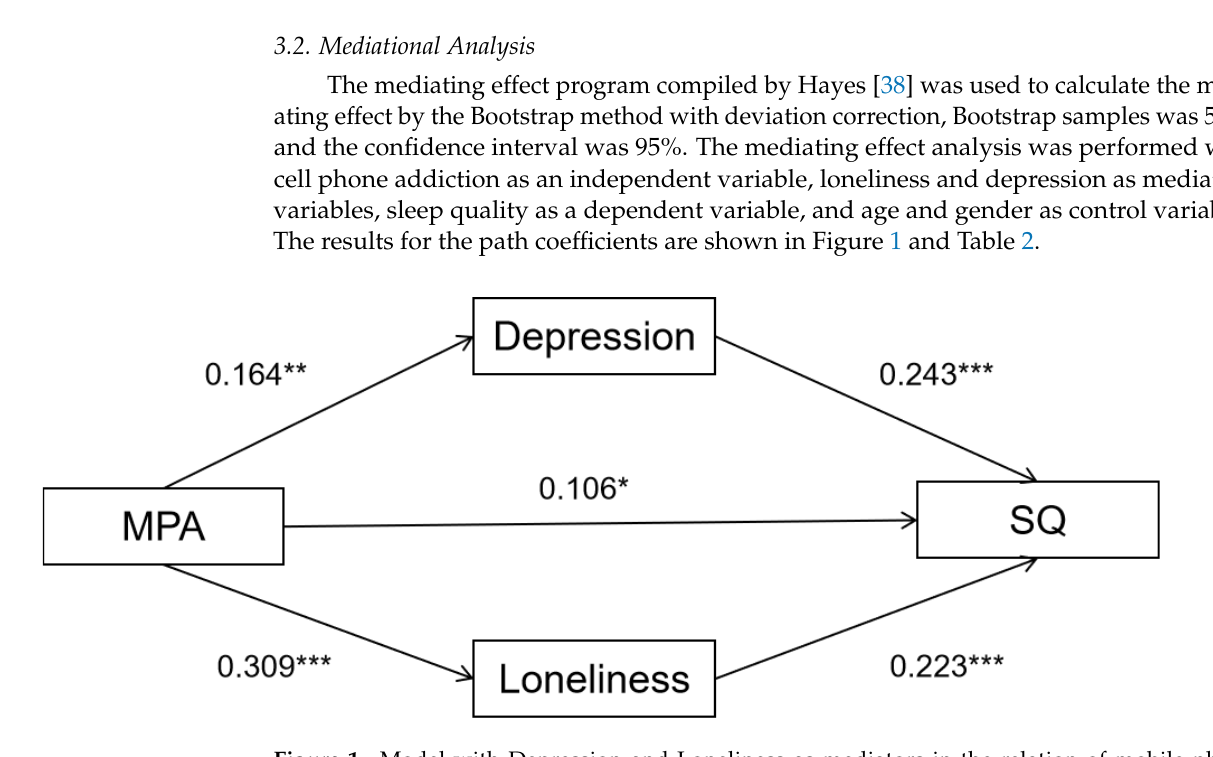
Figure 1. Model with Depression and Loneliness as mediators in the relation of mobile phone ad-